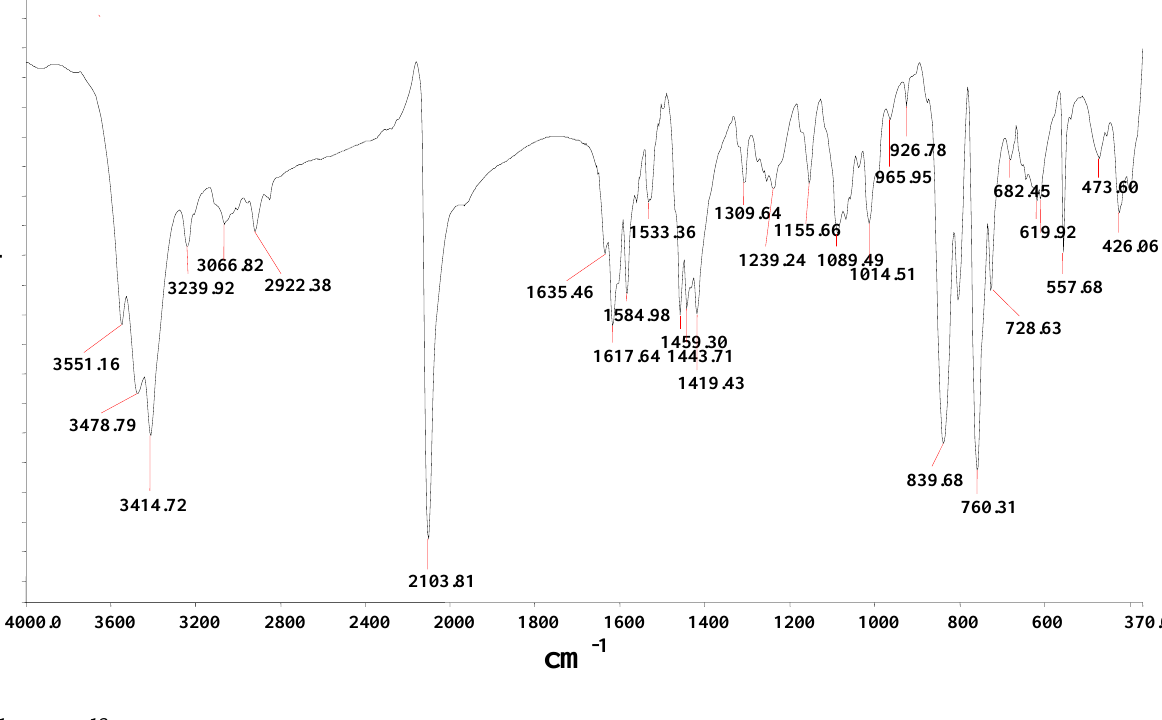
Figure 1. FT-IR spectrum of [ RuL